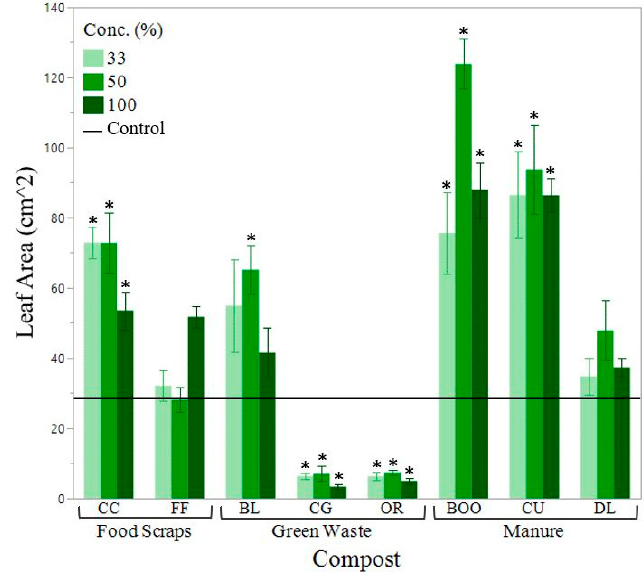
Figure 4. Mean bean plant leaf area in cm 2 by compost type. Leaf area was taken for the second round of growth on bean plants. Compost concentration of the growing media shown from dark to light (100%, 50%, 33% compost). Horizontal solid black line indicates the mean shoot weight of the control (soil). Error bars denote standard error (n = 6). Stars (*) indicate significant from the control α = 0.05).